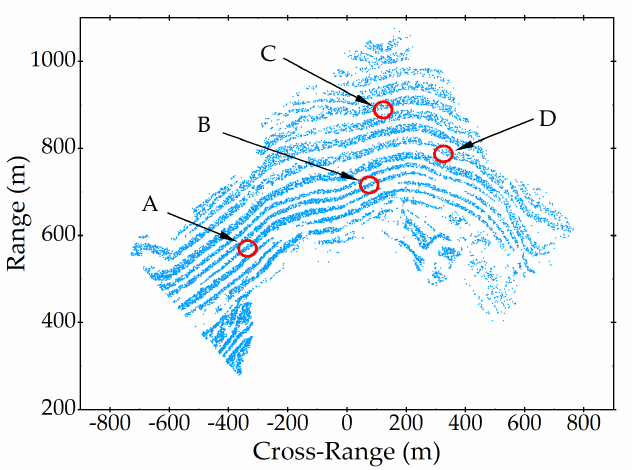
Figure 16. The areas where the deformation was added, A, B, C, and D mark the areas where deformation was